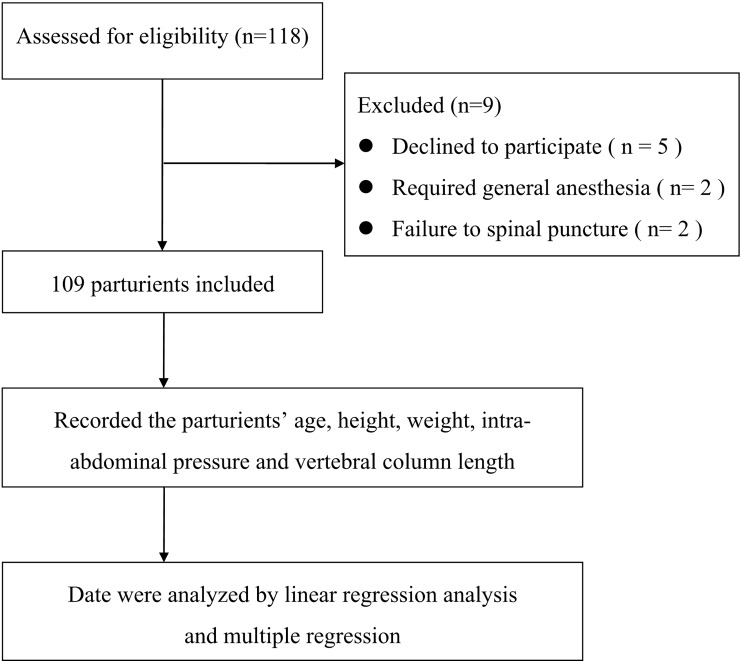
Flow diagram outlining the study procedure.